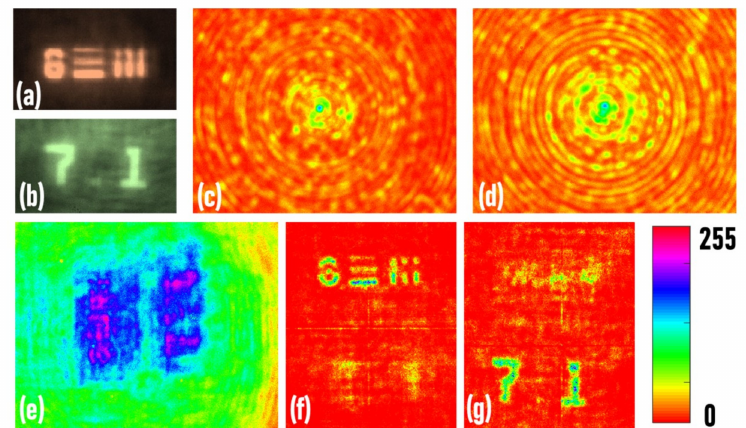
Figure 4. Direct imaging of the ( a ) USAF and ( b ) NBS objects. Point spread holograms recorded for ( c ) λ c = 617 nm and ( d ) λ c = 530 nm. ( e ) Object hologram recorded when the USAF and NBS objects were at the same distance from the HDOE. ( f , g ) The reconstruction results using ( c ) and ( d ), respectively. The scale corresponds to the pixel intensity recorded by the image sensor.